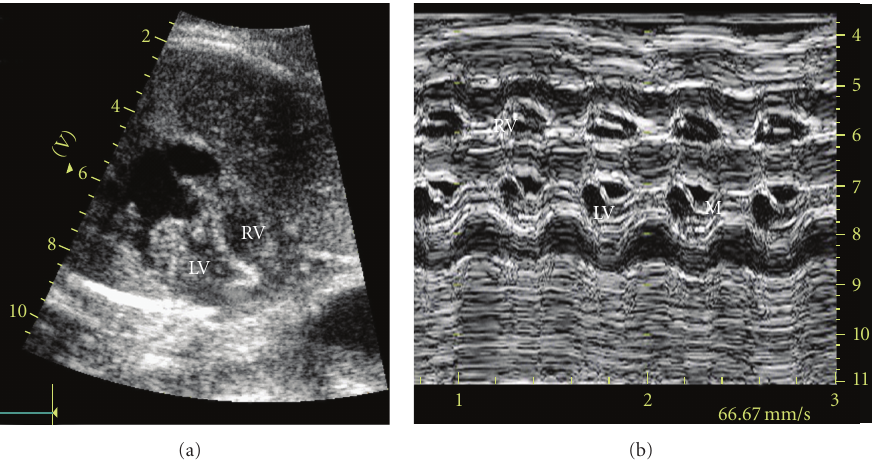
Figure 4: (a) Fetus with hypertrophic cardiomyopathy in 2-D; (b) M-mode recording showing hypertrophy of the left ventricular walls, with a small cavity and mitral valve movement with diastolic apposition and anterior systolic motion. RV—right ventricle, LV—left ventricle, M— mitral